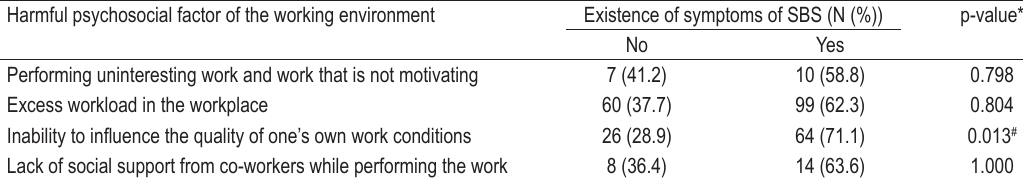
TABLE 2. Participants exposed to a particular harmful psychosocial factor of the working environment according to the existence of symptoms of sick building syndrome